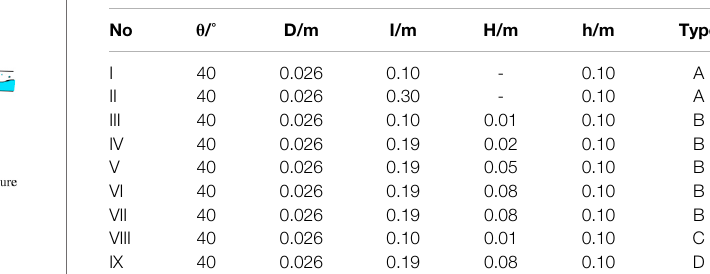
TABLE 1 | Experiment section dimensions description.